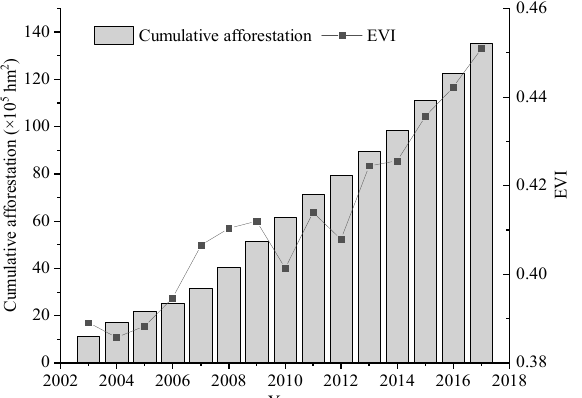
Figure 7. Relationship between cumulative afforestation areas and EVI in the study area from 2003 to 2017.